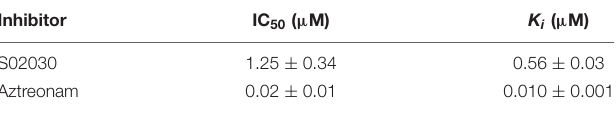
The water molecules were deleted, and the new compounds